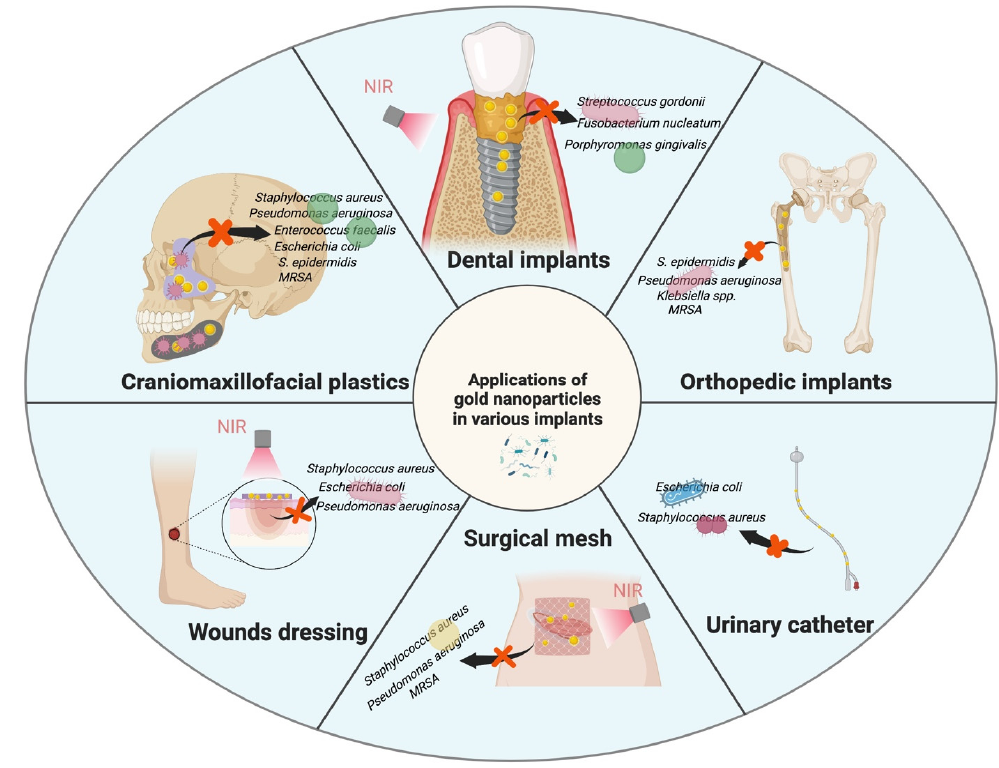
Figure 4. Applications of gold nanoparticles in various implants.